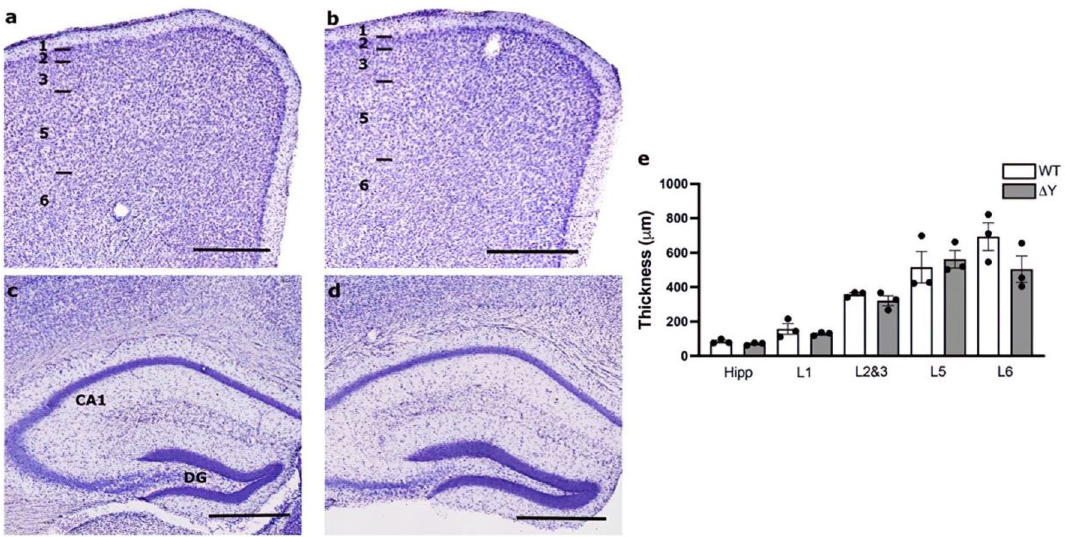
Figure 1. ΔY mutation in MHC-I has no effect on cytoarchitectural stratification. Nissl-stained coronal Sections (50 µm) of adult brains from WT ( a , c ) and ΔY ( b , d ) mice at the prefrontal and hippocampal levels along the rostrocaudal axis of the neocortex. Layers of the neocortex are represented in Panel a 1–3,5,6 . ( e ) Quantification of layer thickness reveals no differences between WT and ΔY mice. Abbreviations: CA1, cornu ammonis 1; DG, dentate gyrus; Hipp, hippocampus; L, layer. Scale bar = 500